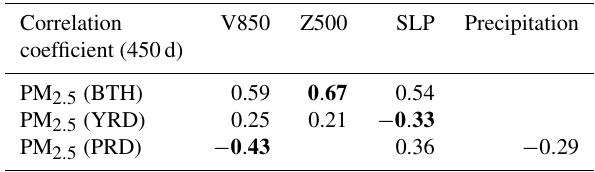
Table 1. Correlation of the area-weighted averages of daily nor- malised circulation variables over the regions marked by yellow rectangles in Figs. 5, 7 and 9 with daily PM 2 . 5 concentrations over BTH, YRD and PRD, respectively, during DJF 2013–2017. All cor- relation values are significant at the 99% confidence level. The highest correlation (absolute value) for each region is shown in